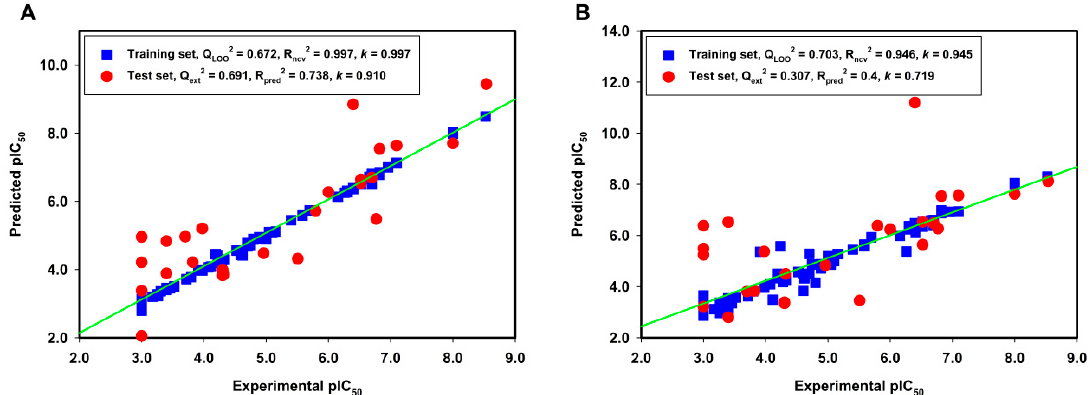
Figure 2. The linear correlation between the experimental and predicted pIC 50 values for the training set (blue square) and the test set (red circle) based on ( A ) the CoMFA model and ( B ) the CoMSIA model derived from the ligand-based alignment method.